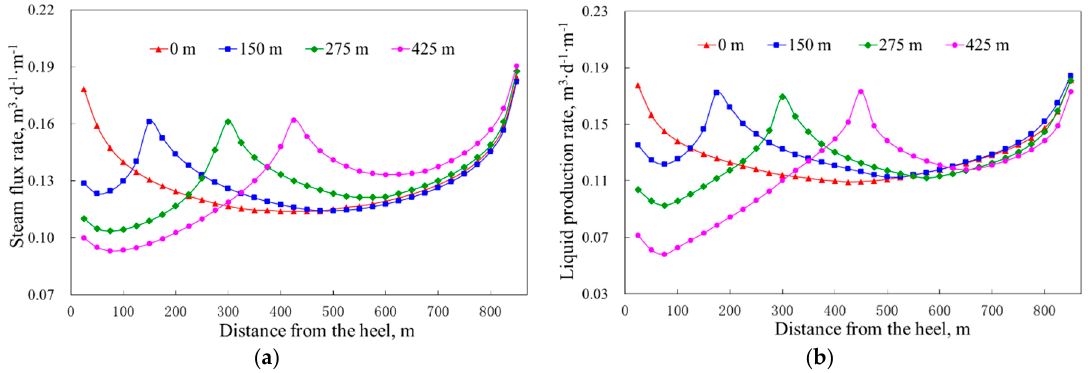
Figure 10. Effect of the injector wellbore configuration on the injection and production profiles: ( a ) steam flux rate; ( b ) liquid production rate.